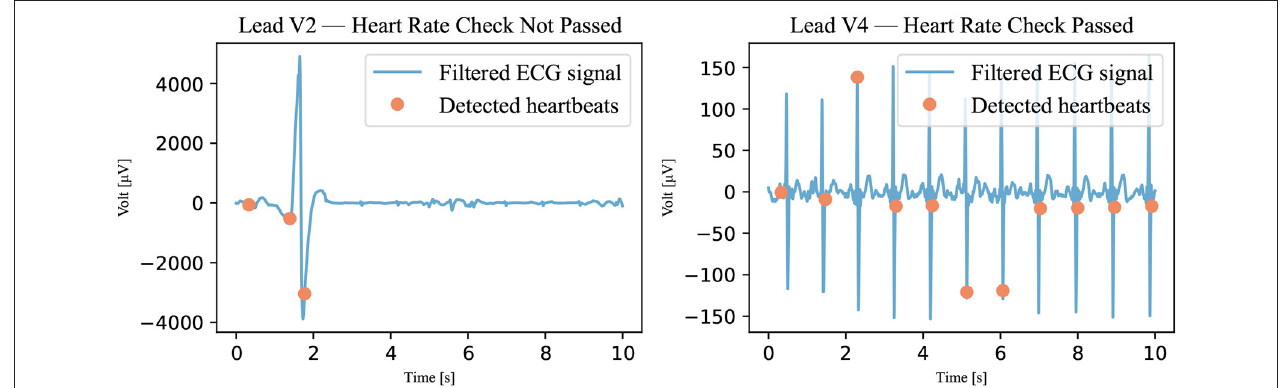
FIGURE 5 | Heart rate check. The filtered signal (Recording 2167341) was analyzed using the Pan-Tompkins algorithm. The detected heartbeats are visible as dots. If the number of detected heartbeats was not within the accepted range, the signal was marked not passed. A signal that has not passed is shown on the left; a signal that has passed is shown on the right.